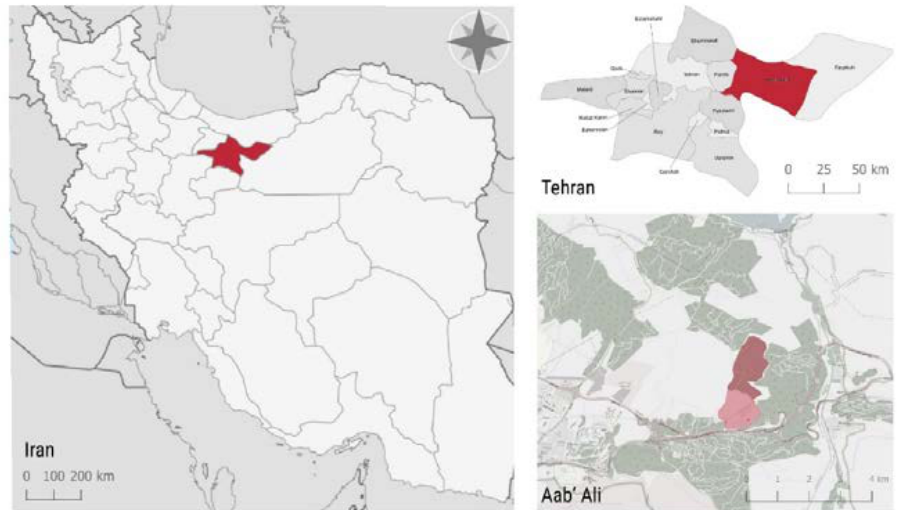
Fig. 1: Geographic location of the study area in Aab’Ali landfill in Tehran, Iran